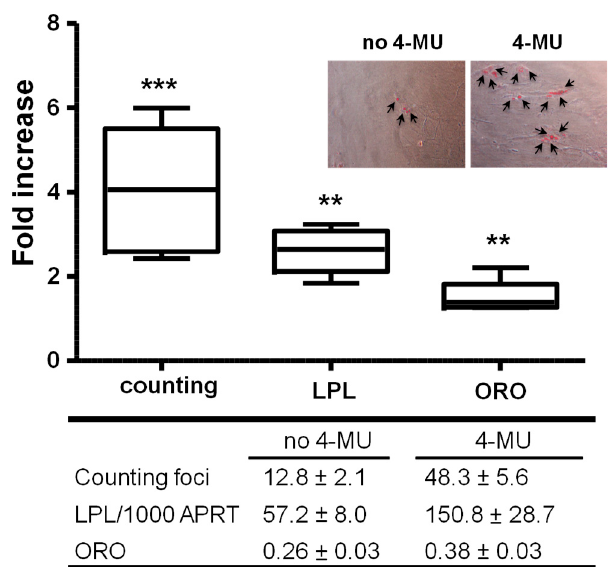
Figure 2. Enhanced adipogenesis by HA synthetic inhibitor, 4-MU . Confluent primary subcutaneous PFs were cultured in adipogenic medium (ADM) or complete medium (CM) with/without 4-MU for 22 days. Total RNA and nuclear protein were prepared. Fold effect (relative to the untreated control) of adipogenesis using foci counting (representative photos were shown with arrows indicating differentiating adipocytes), lipoprotein lipase (LPL) transcripts and oil red O (ORO) staining methods ( n = 6). The table reports QPCR results together with foci numbers and ORO optical density values as the mean ± SEM. p -values are indicated in the figure above. ** p ≤ 0.01; *** p ≤ 0.006.